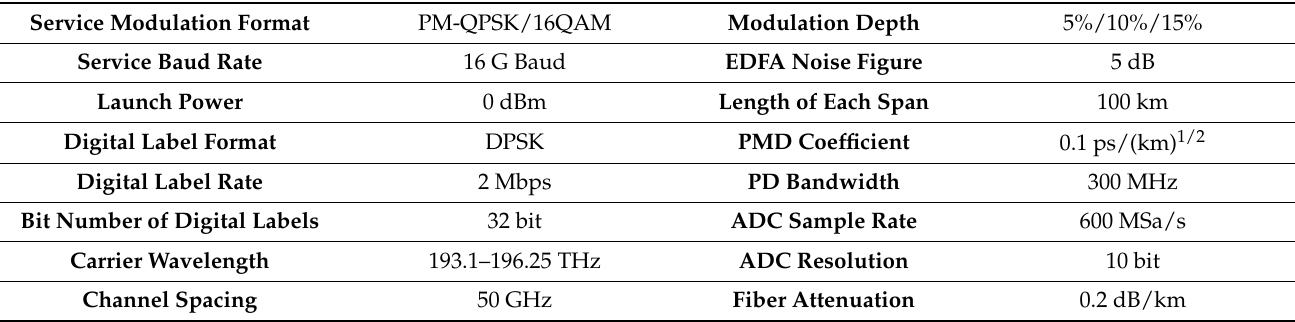
Table 2. Simulation parameters.